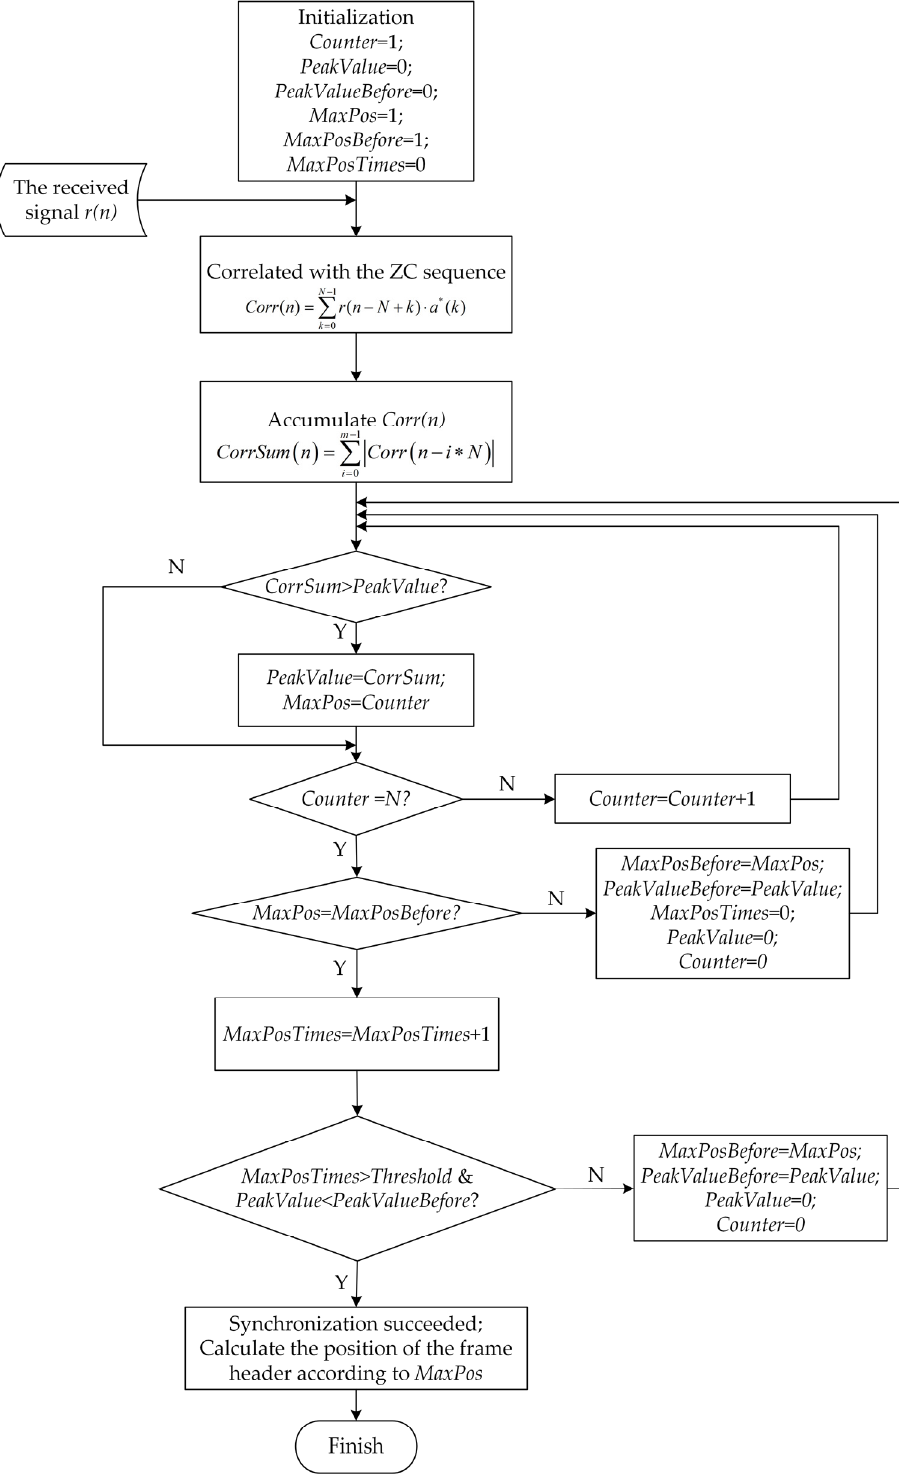
Figure 7. The fl owchart of the accumulated correlation peak detection (ACPD) algorithm. Figure 7. The flowchart of the accumulated correlation peak detection (ACPD)